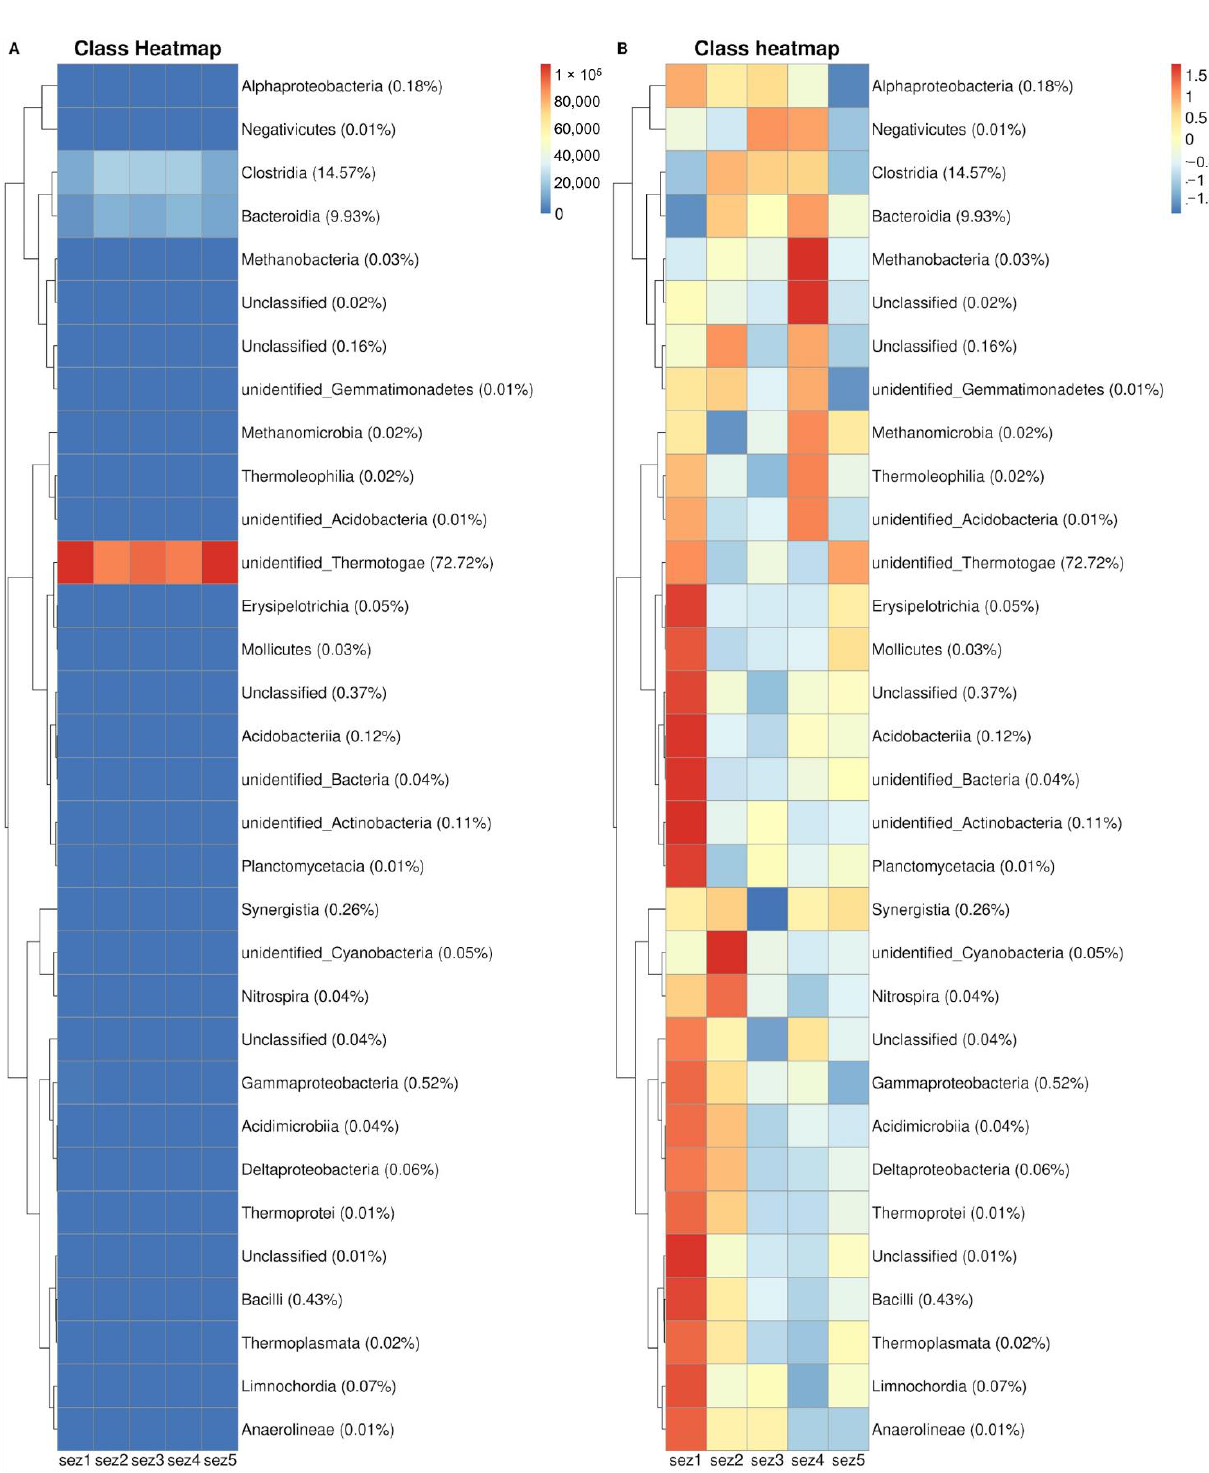
Figure 7. Taxonomic heatmaps at the class level. Taxonomic heatmaps showing the most abundant ASVs per section: ( A ) absolute counts and ( B ) autoscaled counts, aggregated at the class level. Percentages reported near the ASV names represent the relative abundance of the sum of ASV counts per sample against the total sum: a cut-off value of 0.005% was chosen. Hierarchical clustering was performed on rows by Pearson correlation, based on Euclidean distance. In order to evidence variation, the color scheme of panel B, representing row-wise Z-scores of ASV counts per sample, was chosen. For this color scheme, a Z value of 0 matches the reported percentage near the ASV names.